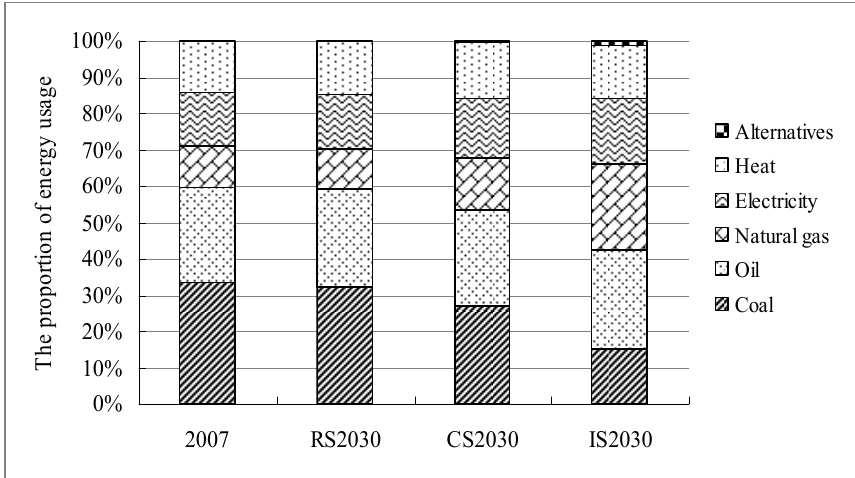
Figure 2. Structure of final energy usage under the RS, CS, and IS in